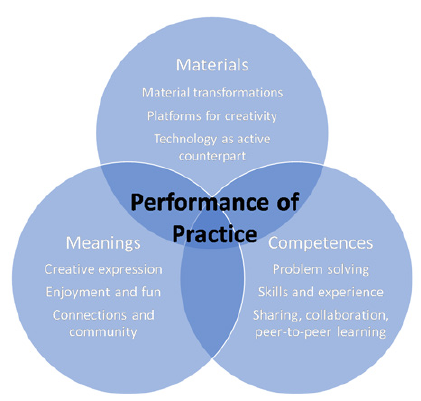
Figure 6. The elements of making (source: created by